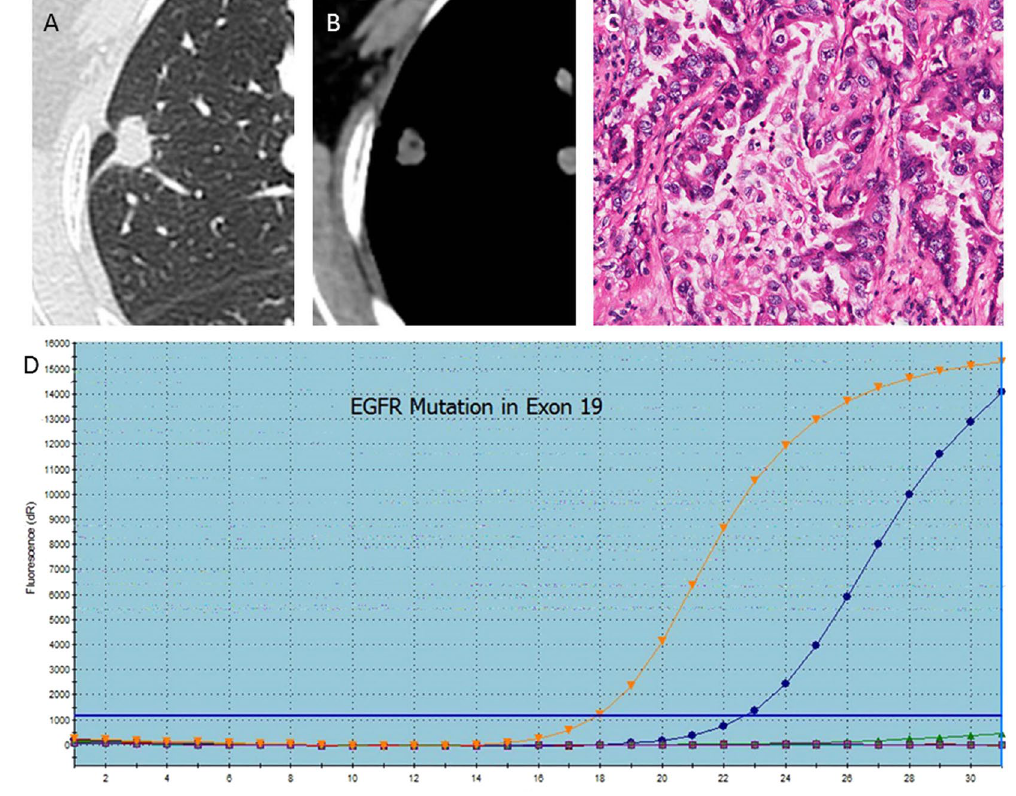
Figure 4. A 62-year-old woman with EGFR mutation of lung adenocarcinoma in the right upper lobe, where the pathological type ( A ) is EGFR mutation in exon 19, and CT images ( B,C ) show a small